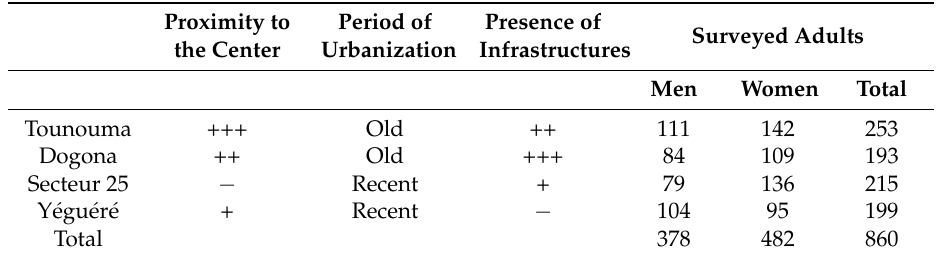
Table 1. Features of the chosen sub-spaces and distribution of surveyed adults in the different sub-spaces. Proximity to Period of Presence of Surveyed Adults the Center Urbanization Infrastructures Men Women Total Tounouma +++ Old ++ 111 142 253 Dogona